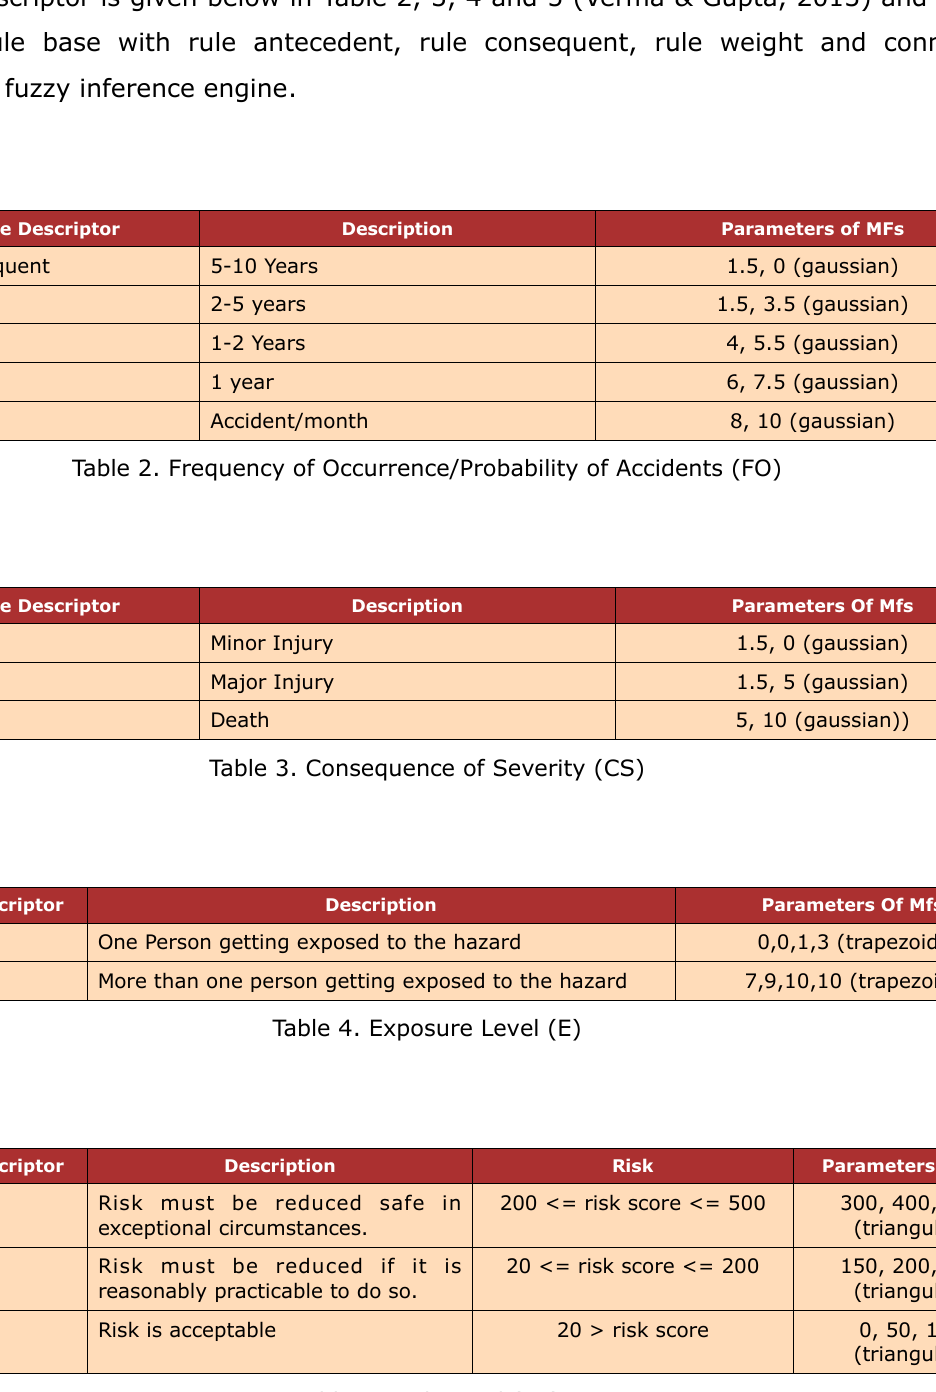
Table 5. Risk Level